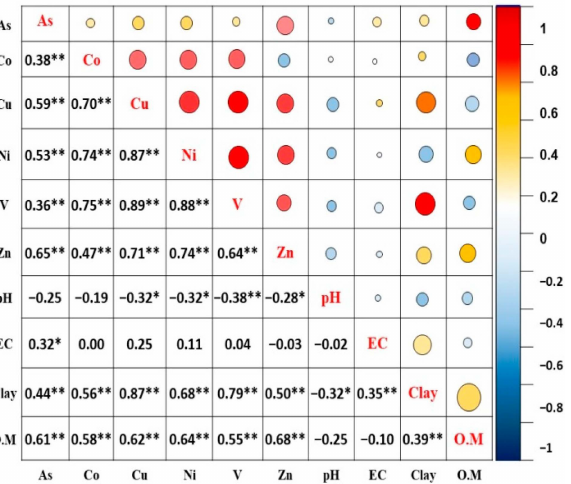
Figure 3. Pearson Correlation matrix chart of the studied variables. Note: * p < 0.05; ** p <